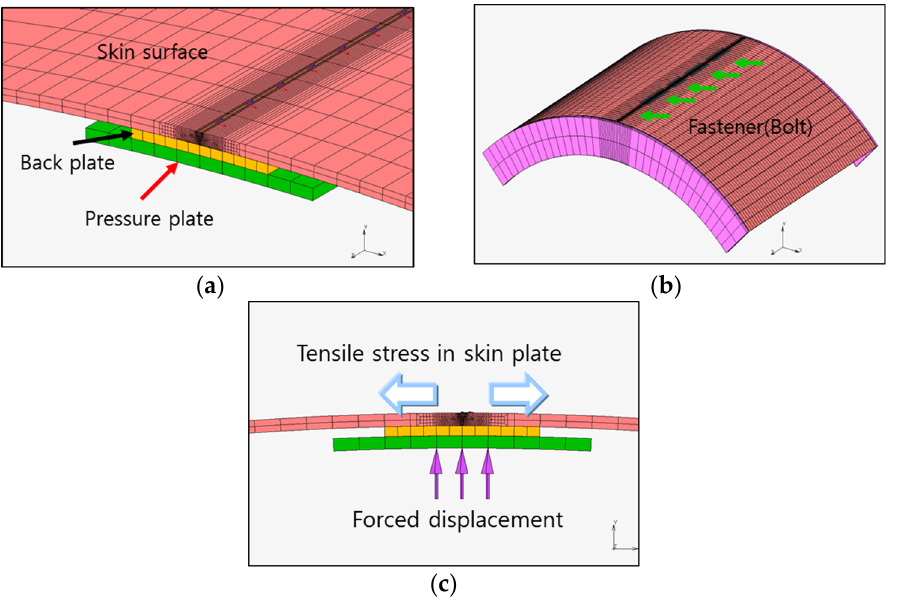
Figure 5. Modeling of pre-stress method: ( a ) pressure plate; ( b ) bolting; ( c ) forced displacement [27].